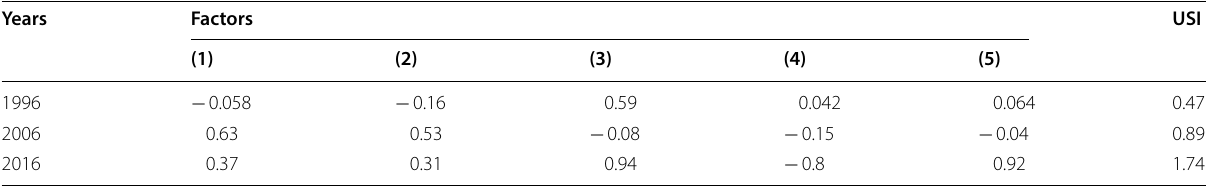
Table 5 Estimation of the factor scores and urban sprawl index (USI) within three time windows of 1996, 2006, and 2016 in Mashhad city